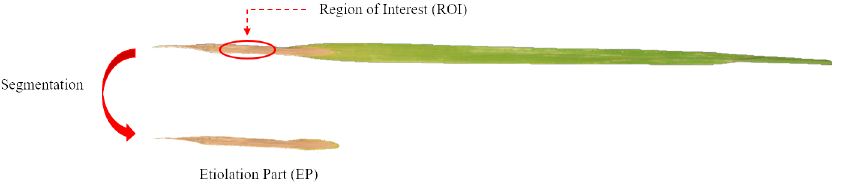
Fig 1. Segmentation of etiolated leaf tip. Etiolation area (EA) and degree of leaf etiolation (ED) were extracted from the 3 rd leaf.